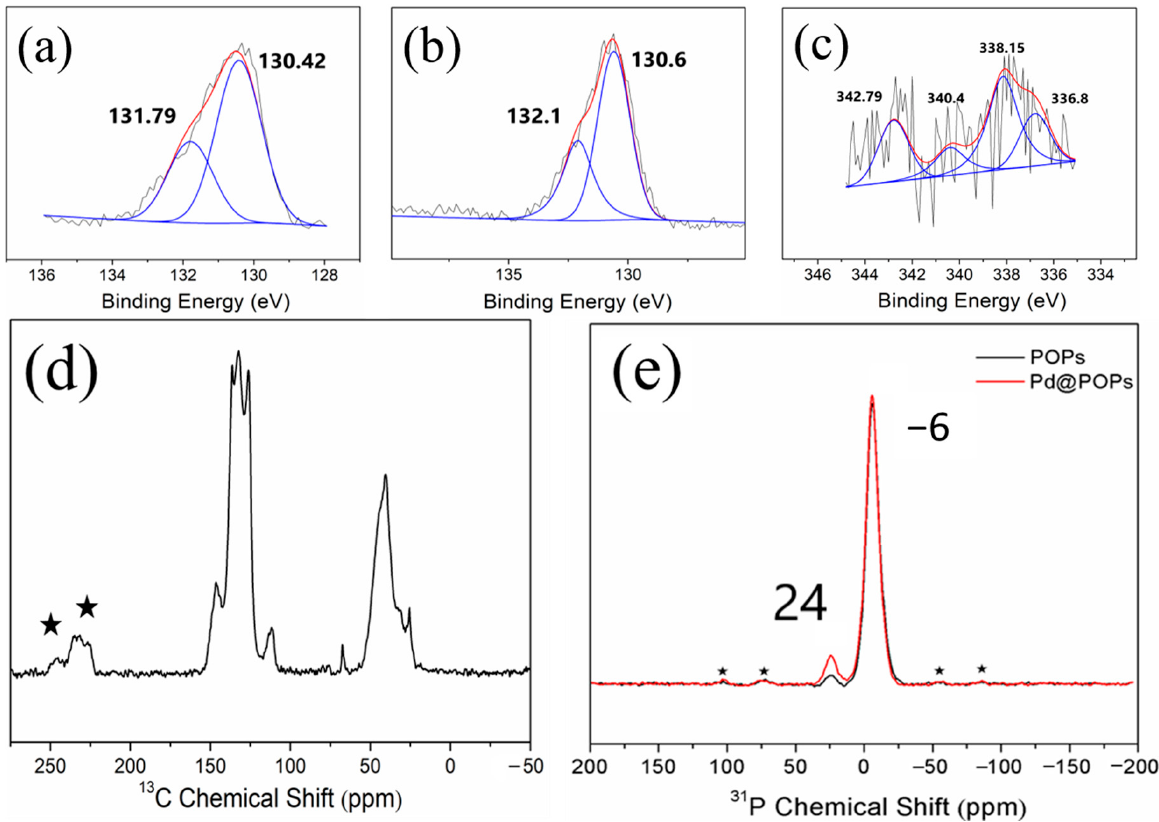
Figure 3. The XPS spectra of ( a ) P2p for POP and ( b ) P2p and ( c ) Pd3d for Pd@POPs. ( d ) The solid-state 13 C NMR spectrum of Pd@POPs. ( e ) The solid-state 31 P NMR spectrum of POP (black) and Pd@POPs (red). The peaks of spinning sidebands are marked with stars. For ( a – c ), the black lines are composed of original data, the red lines are fitting curves and the blue lines are got by peak fitting.